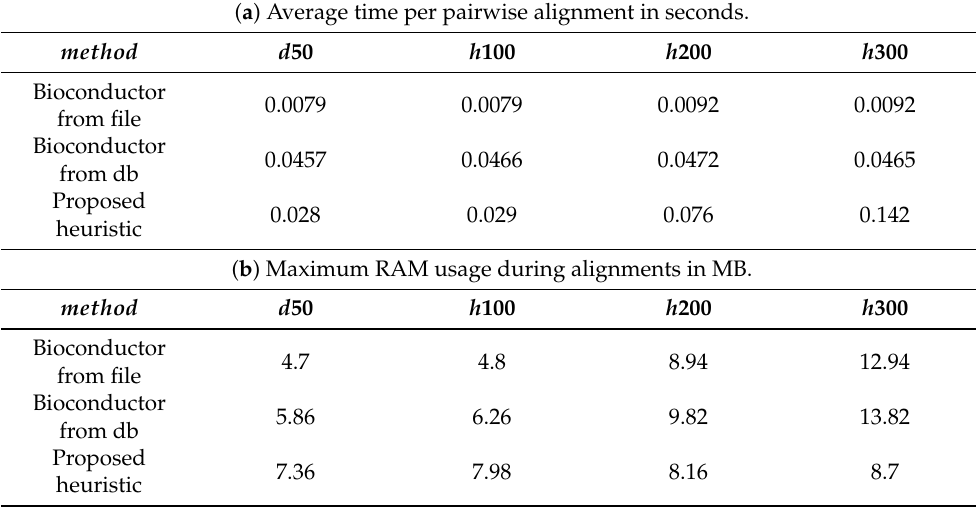
Table 6. Time and peak memory usage of the proposed heuristic approach and a classical global pairwise algorithm for each data